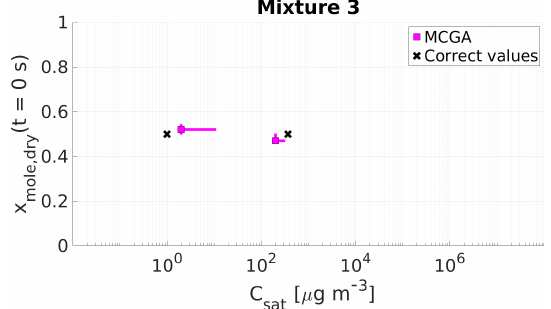
Figure 9. Parameter estimates for particles generated from mix- ture 3. Dry particle mole fraction at the start of the evaporation of two compounds and their saturation concentrations and the viscos- ity parameters b i were optimized to match the evaporation data. Magenta squares show the MCGA estimates and black crosses show the literature values. The whiskers show the 10th and 90th percentiles of the estimated variable distributions. Sucrose C sat is marked at the lower limit of the C sat range due to its assumed low value.